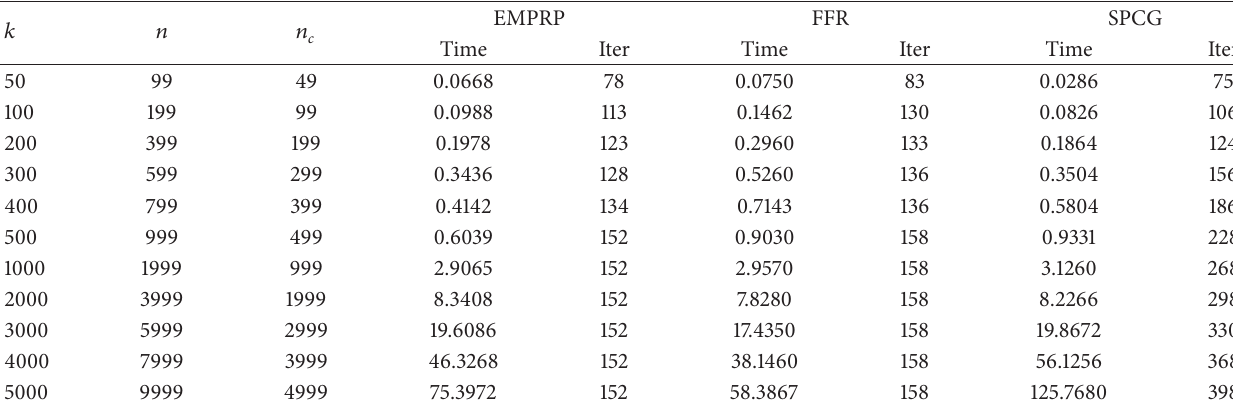
Table 4: Test results for Problem 8 with given initial points.